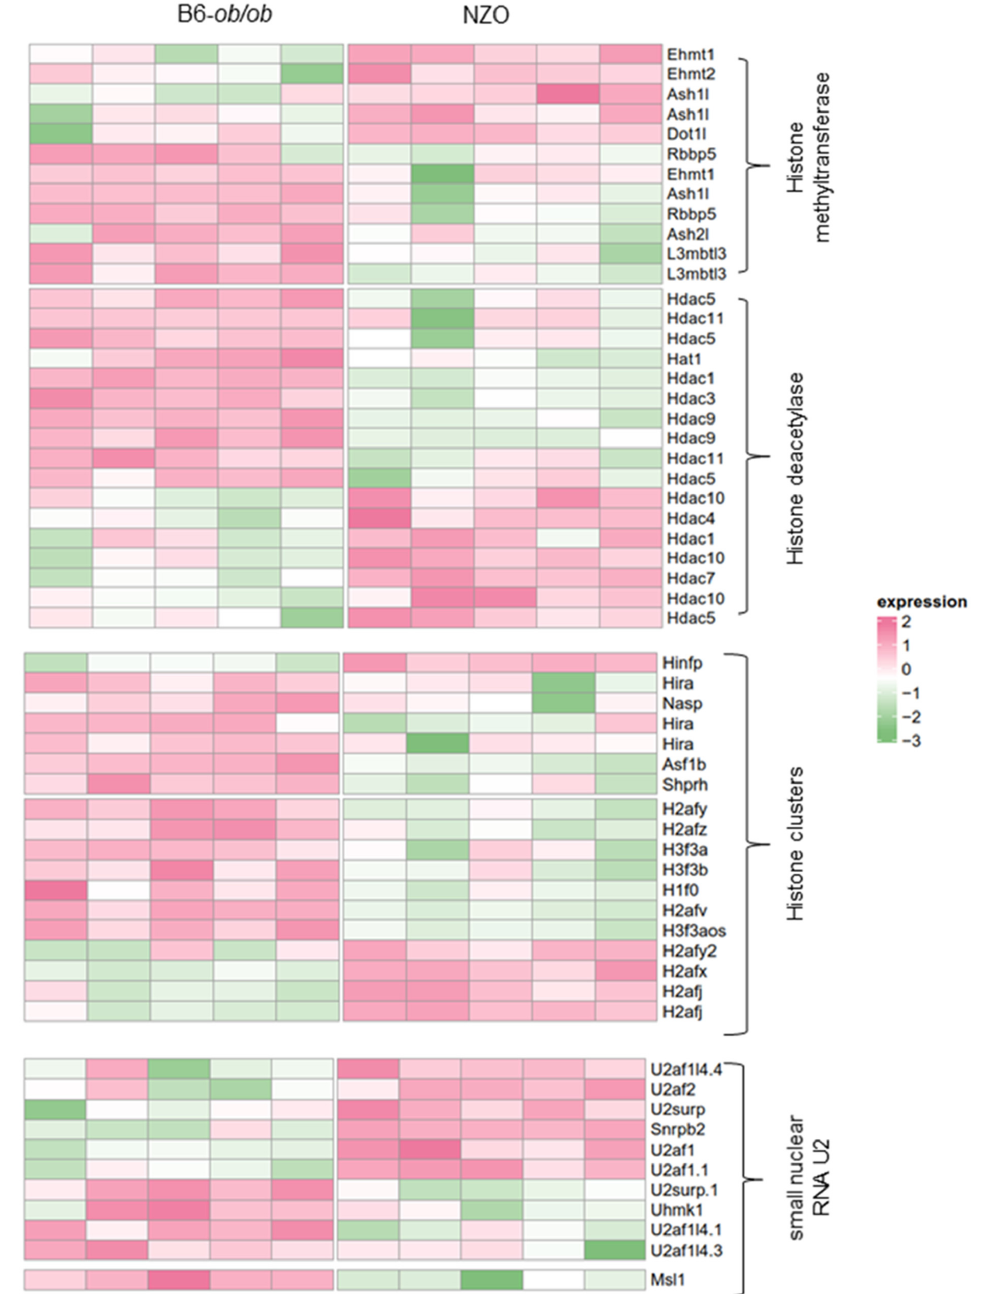
Figure 2. Differential expression of histone and chromatin modifiers. Heatmaps showing expression levels of the indicated genes. Each column represents the individual expression level in islets of B6-ob/ob and NZO mice; each row shows the expression profile of one single transcript with significant differences. Up- and downregulated genes are indicated by light pink and light green signals, respectively; the signal intensity corresponds to the log-transformed scaled magnitude of the individual FPKM (Fragments Per Kilobase Million) levels. Five animals were used per group to perform Welch test.